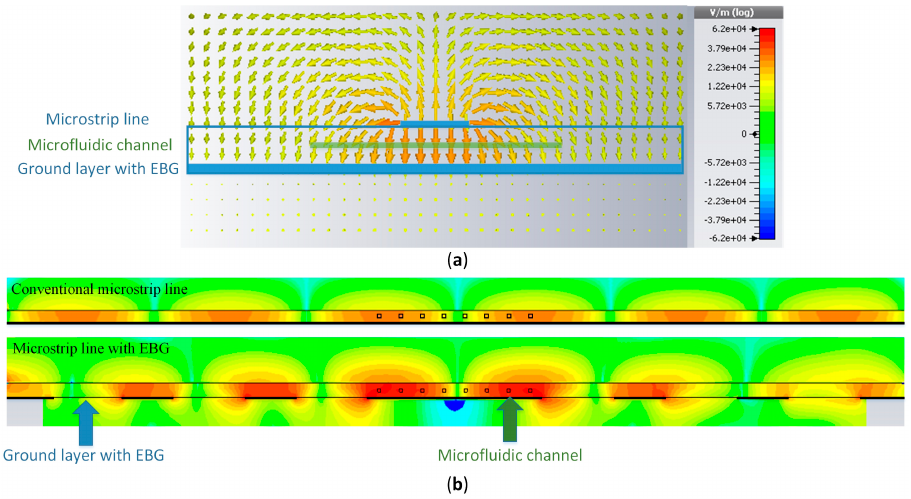
Figure 2. Electric field distribution of the proposed microfluidic EBG sensor: ( a ) orthogonal cross-section view; ( b ) comparison of the intensity of the electrical field along the microstrip line for conventional microstrip line and microstrip line with EBG.